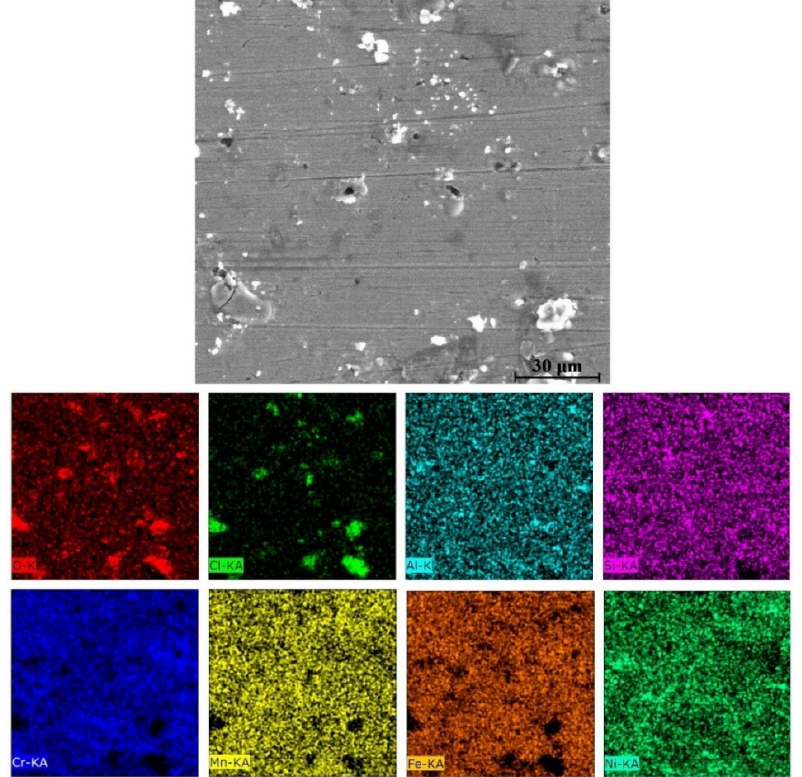
Figure 19. EDX elemental mapping of the corroded solution-treated Fe 36 Mn 20 Ni 20 Cr 16 Al 5 Si 3 HEA in 0.6 M NaCl with 1 M H 2 SO 4 .